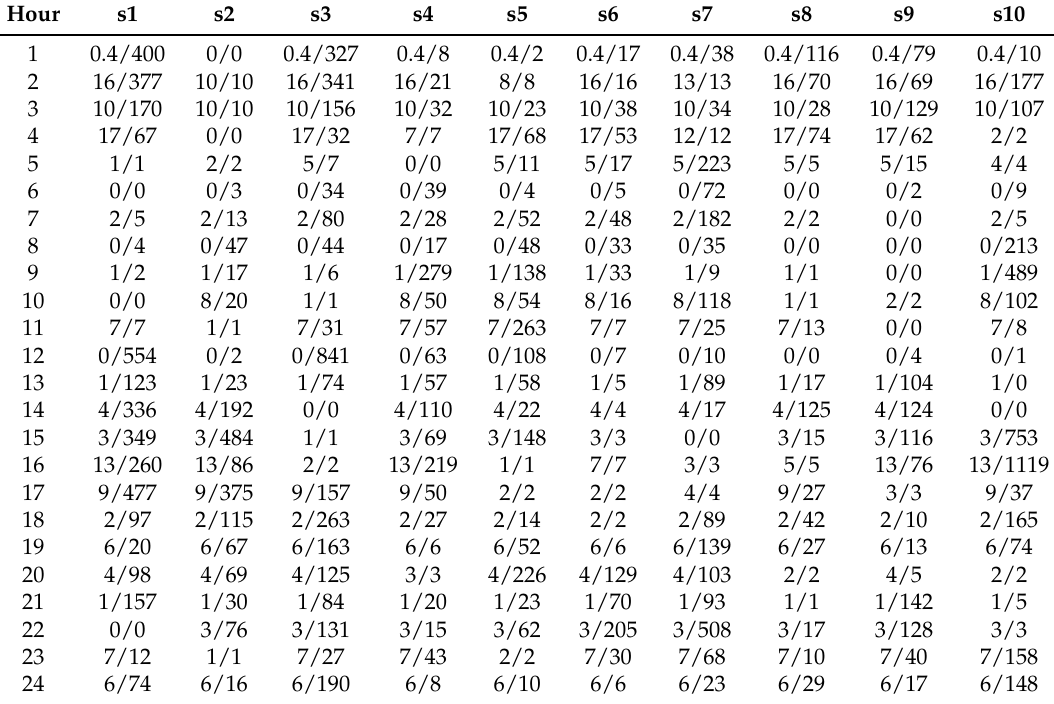
Table 3. Volume of up reserve activation provided by the battery per scenario as a portion of the overall activated reserve (rounded to an integer unless close to zero), in MWh.